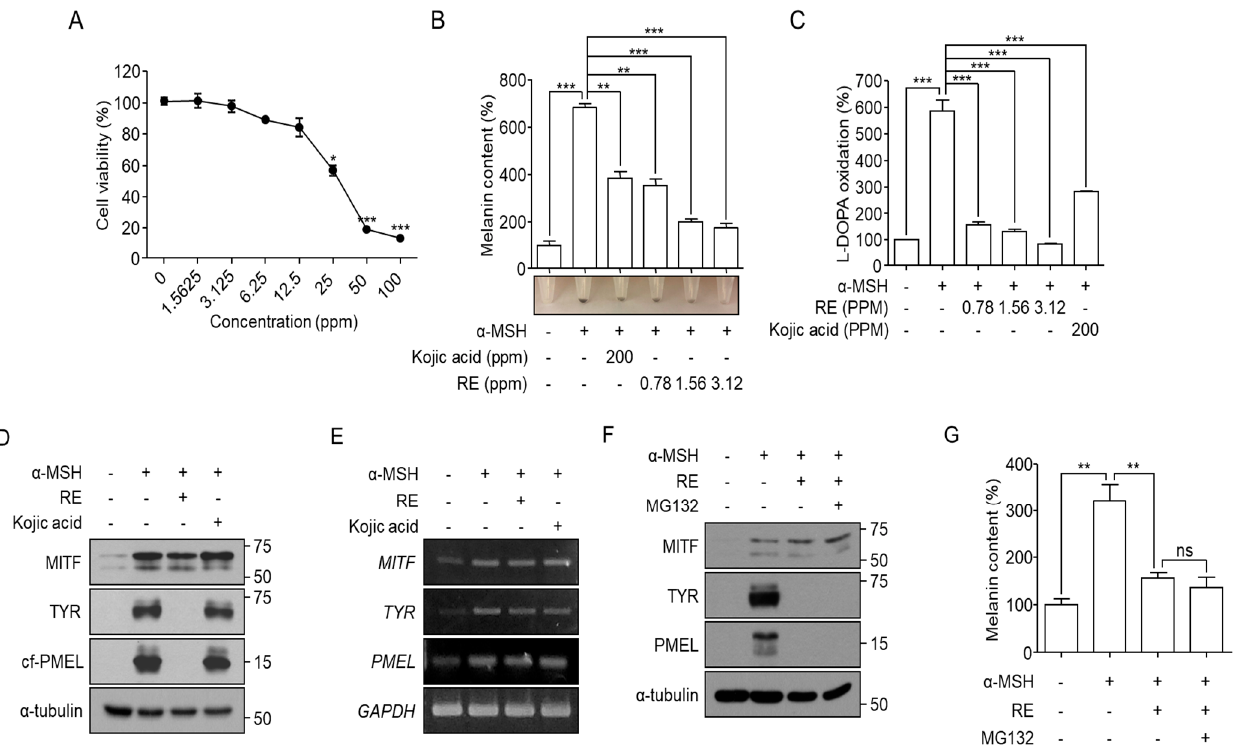
Figure 1. Depigmentation effect of A. fruticosa L. RE in α -MSH-stimulated B16F10 cells. ( A ) B16F10 cells were incubated with A. fruticosa RE for 48 h. Following incubation, cell viability was measured using an MTT assay. ( B , C ) B16F10 cells were treated with 1 μ M α -MSH in the presence or absence of kojic acid or A. fruticosa RE for 48 h. After harvesting, cellular melanin content ( B ) and L-DOPA oxidation ( C ) were measured. ( D , E ) B16F10 cells were treated with 1 μ M α -MSH in the presence or absence of 200 ppm of kojic acid as a positive control or 3.12 ppm of A. fruticosa RE for 48 h. The indicated protein ( D ) or mRNA expression ( E ) levels were analyzed by Western blotting or RT-PCR, respectively. ( F , G ) Following treatment of B16F10 cells for 48 h with 3.12 ppm of A. fruticosa RE in the presence or absence of 120 nM MG132, the indicated protein levels ( F ) and mela- nin content ( G ) were analyzed. Data were obtained from at least three independent experiments, and the values represent the mean ± SEM. ns, not significant, * p < 0.05, ** p < 0.01, and *** p < 0.001 according to t